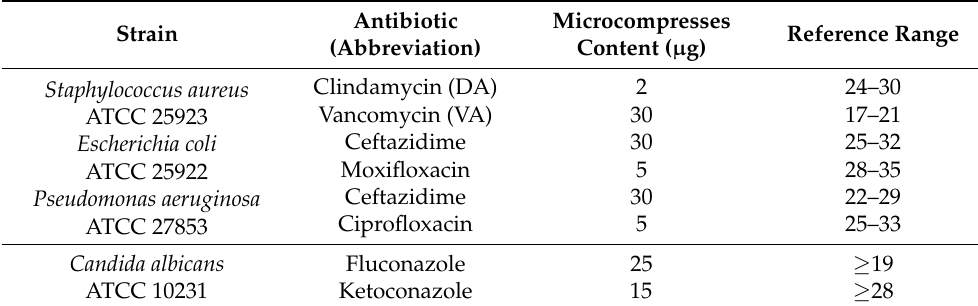
Table 8. Antibiotic disks used, contents, and reference range according to CLSI